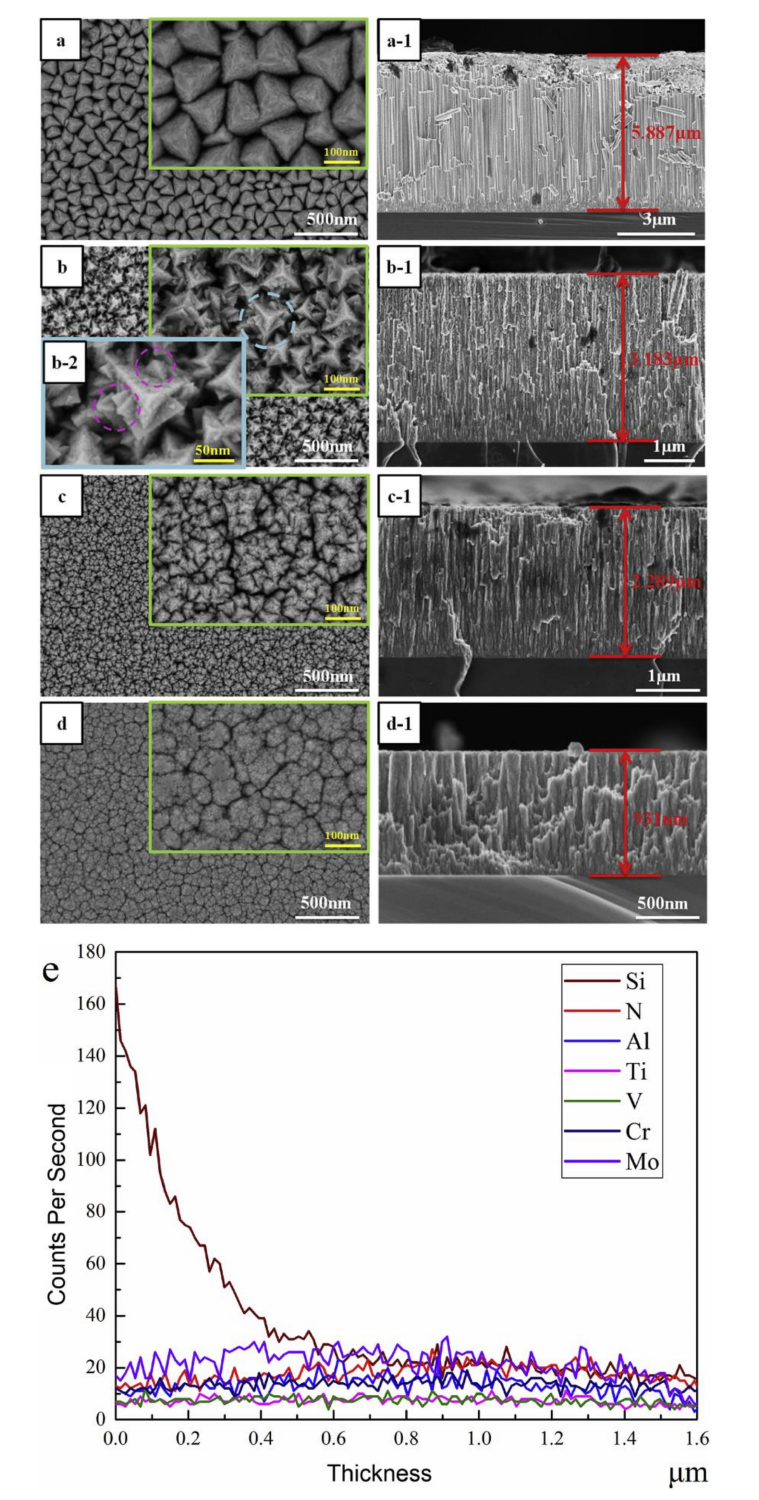
Figure 8. SEM micrographs of surface and cross-section morphologies of ( a ) VAlTiCrMo, ( b ) (VAlTiCrMo)N x -100, ( c ) (VAlTiCrMo)N x -450 and ( d ) (VAlTiCrMo)N x -800 coatings, ( e ) the energy-dispersive spectrometry scanning of element distribution along the thickness direction of the (VAlTiCrMo)N x -800 coating. Reproduced from Chen et al. [183]. Copyright 2020 Elsevier B.V. All rights